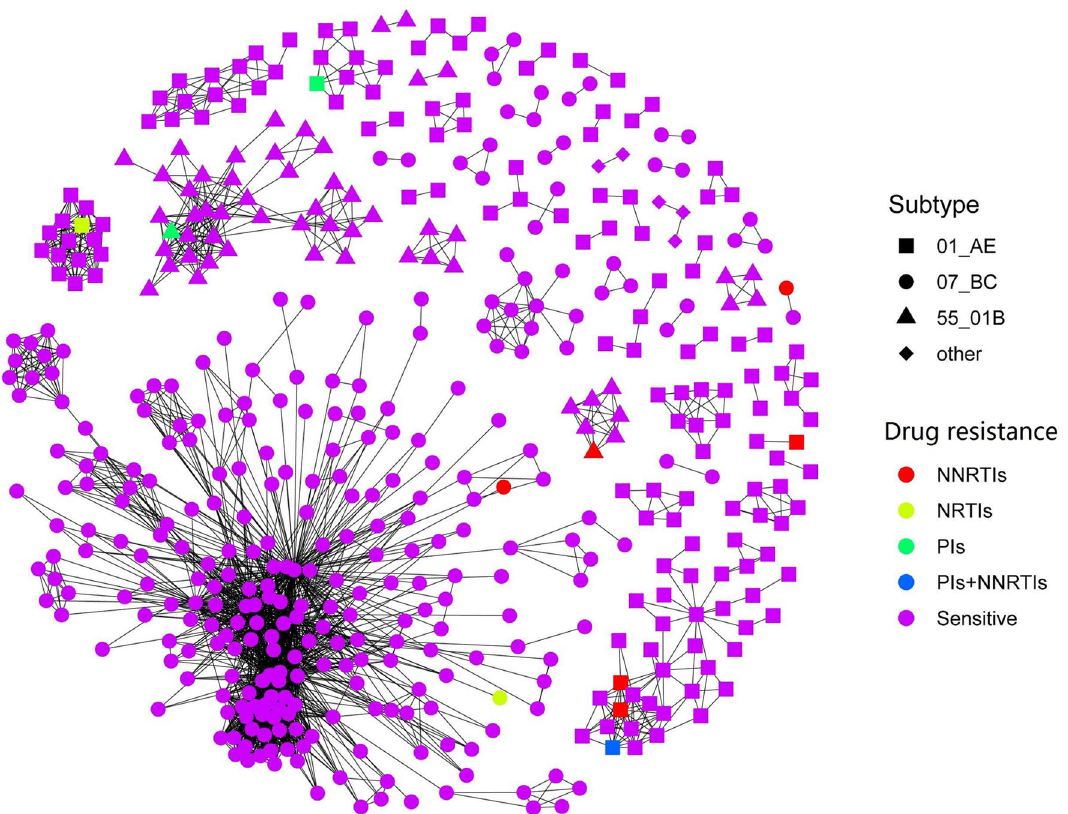
Figure 5. Drug-resistance-associated genetic transmission networks. The network was constructed using a custom R script with the network package in R version 4.0.2 software. Different shapes represent different subtypes. Different colours represent differences in drug resistance. PIs protease inhibitors, NRTIs nucleoside reverse transcriptase inhibitors, NNRTIs non-nucleoside reverse transcriptase